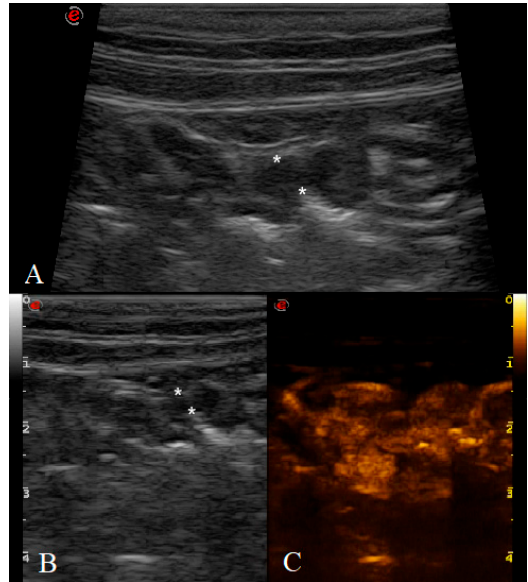
Figure 2. Cat affected by gastric low-grade lymphoma (LGAL) showing: ( A ) diffuse reduced layer definition associated with mild increases in wall thickness (3.8 mm between the asterisks) on B-mode examination; ( B , C ) B-mode ( B ) and contrast-enhanced ultrasonography (CEUS) ( C ) clip acquired using dual-mode visualization in order to better identify the gastric wall during CEUS examination.